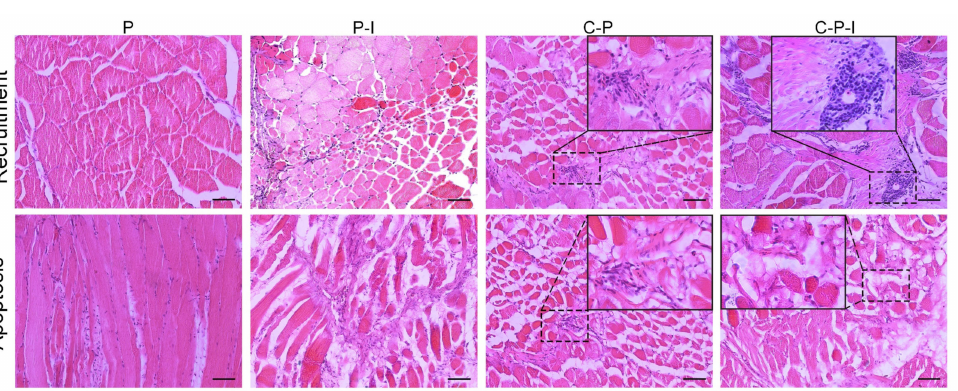
Figure 5. Histological changes in muscle after vaccination. Injection of plasmids leads to local recruitment of inflammatory cells and apoptosis of some muscle cells. Muscle sections (7 µ m thick) obtained on 5th day following immunization of grouper with P, P-I, C-P, and C-P-I, respectively, were stained with hematoxylin and eosin. The picture in the box is a magnification of the corresponding area. P: pBudCE4.1 group; P-I: pBudCE4.1-IRF3 group; C-P: CP-pBudCE4.1 group; C-P-I: CP- pBudCE4.1-IRF3 group. Scale bar: 50 µ